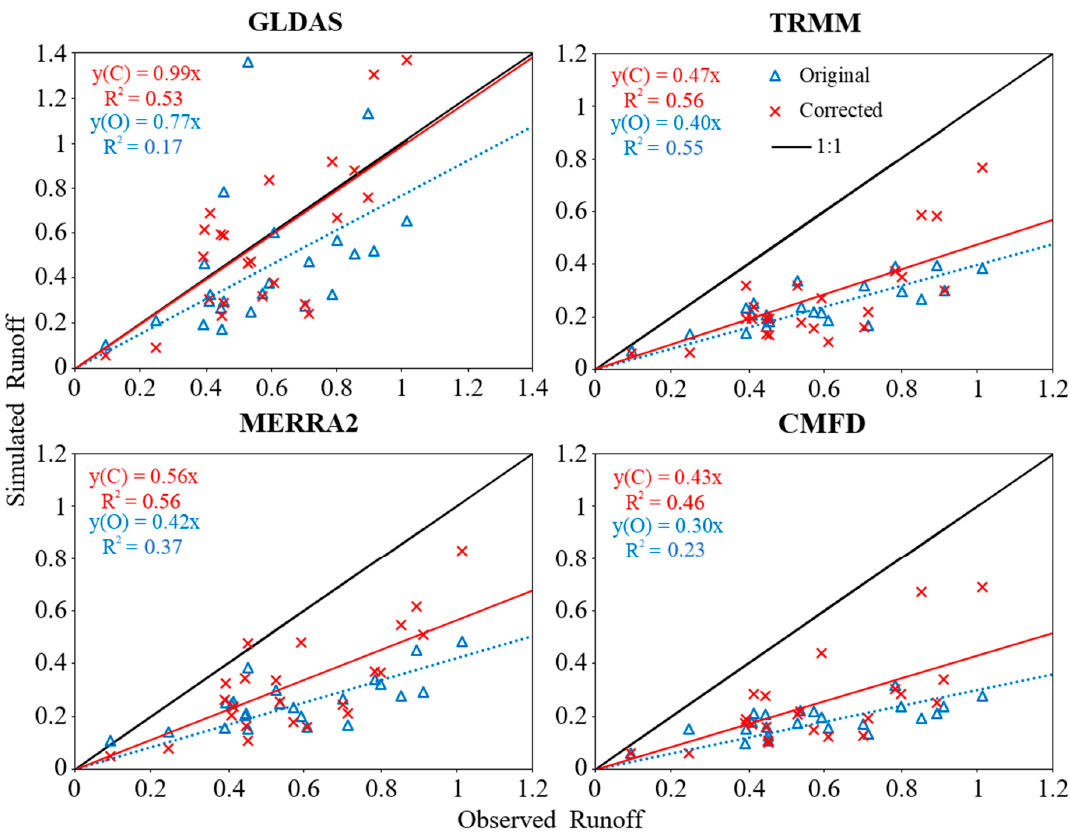
Figure 11. Scatterplot of monthly runoff (standard) simulated by original and corrected precipitation. Table 1. The R 2 and proportionality coefficient (k) of monthly precipitation in each product over all stations.